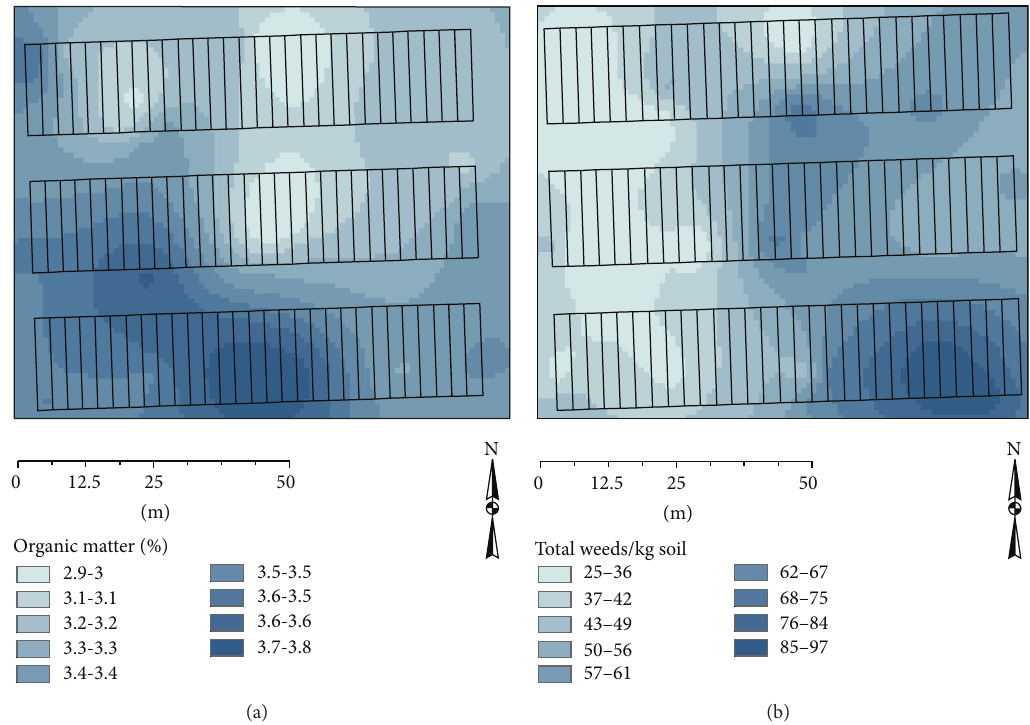
Figure 4: Isopleth maps for organic matter (a) and total weeds (b) were calculated using kriging with the gstat package in R.